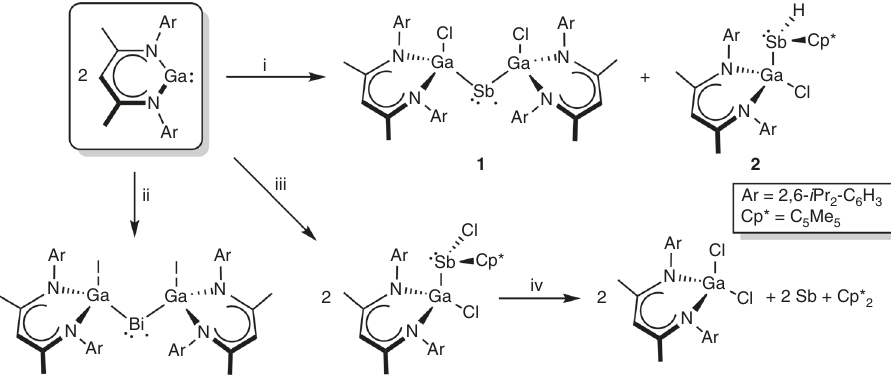
Fig. 2 Synthesis of 1 – 4 . i stirring LGa and 0.5 eq. of Cp*SbCl 2 at 25 °C in benzene for 7 d with elimination of 0.5 Cp* 2 . ii stirring LGa and 0.5 eq. of Cp*BiI 2 from − 40 to 25 °C in toluene over 4 h with elimination of 0.5 Cp* 2 . iii stirring LGa and an equimolar amount of Cp*SbCl 2 in benzene at 25 °C for 1 h. iv stirring 3 in benzene at 25 °C for 6 atoms exhibit equivalent hyper fi ne couplings of A ( 69 Ga) = [132, 176, 134] MHz, a iso = 147 MHz with ρ (Ga s) = 0.012. Given the p- orbital character of the SOMO, a signi fi cant dipolar character is